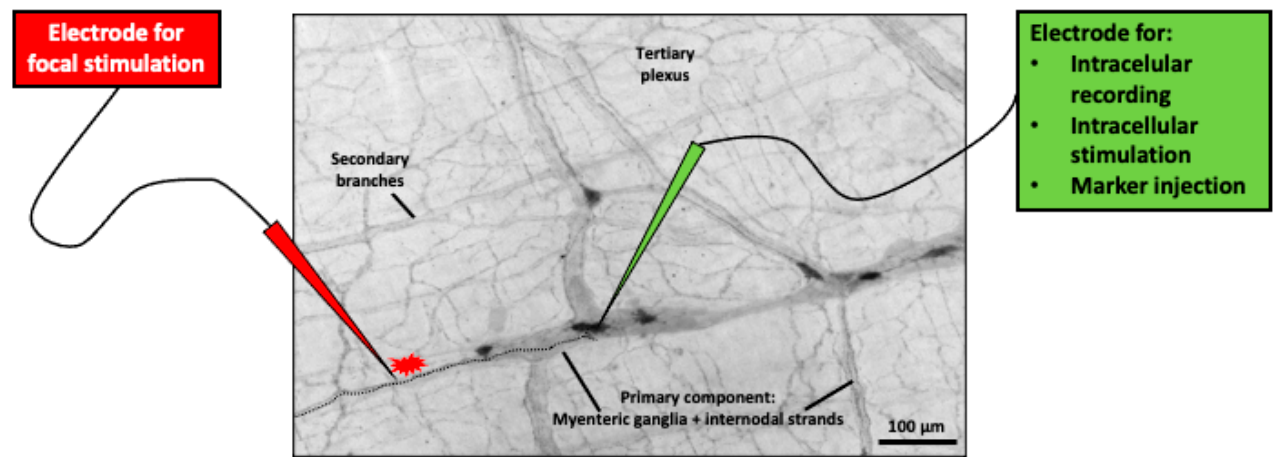
Figure 2. Intracellular recording from myenteric neurons. A fixed whole-mount preparation, processed immunohisto- chemically to show calretinin positive neurons, is used to illustrate how electrical activity of myenteric neurons would be recorded using current clamp electrophysiological modality. Calretinin immunoreactivity in guinea pig ileum whole-mount preparations allows one to distinguish the different components of the myenteric plexus: the primary component, which includes the myenteric ganglia and the internodal strands; the secondary branches that run circumferentially; and the tertiary plexus, a web of fine nerves that correspond to axons derived from excitatory longitudinal muscle motor neurons [165]. The intracellular recording electrode is represented in green (right)—this electrode allows for the recording of neuronal electrical activity, as well as direct intracellular stimulation of the cell with depolarizing or hyperpolarizing continuous or pulsed current, and marker injection to allow the impaled neuron to be visualized after immunohistochemical processing. The electrode for focal, extracellular stimulation is represented in red (left); this is placed on top of a circumferential internodal nerve strand. If the strand carries an axon (represented as a dotted line) that synapses on the impaled neuron, then focal stimuli (represented as a red blast symbol) will cause neurotransmitter re- lease from the axon terminal and a postsynaptic potential on the impaled neuron (see Figure 3 for morphological and electrophysiological classifications of myenteric neurons).